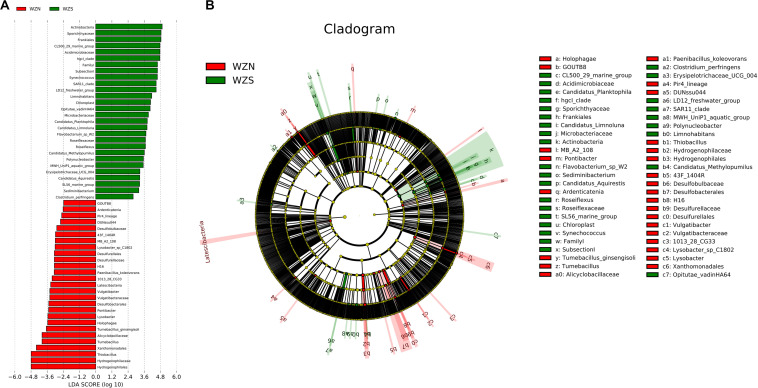
Biomarker analysis of the water and sediment microbial communities from the WZS and WZN. (A) Differentially abundant taxa, the length of the histogram represents the impact of the different species [linear discriminate analysis (LDA) = 2]. (B) Cladogram showing the phylogenetic structures of the microbiota. In the branching diagram of their evolution, the circles that radiate from inside to outside represent taxonomic levels from kingdom to species, and each small circle at a different taxonomic level represents a species at that taxonomic level. The diameter of the circles is proportional to the relative abundance. Species that are not significantly different are uniformly colored yellow.